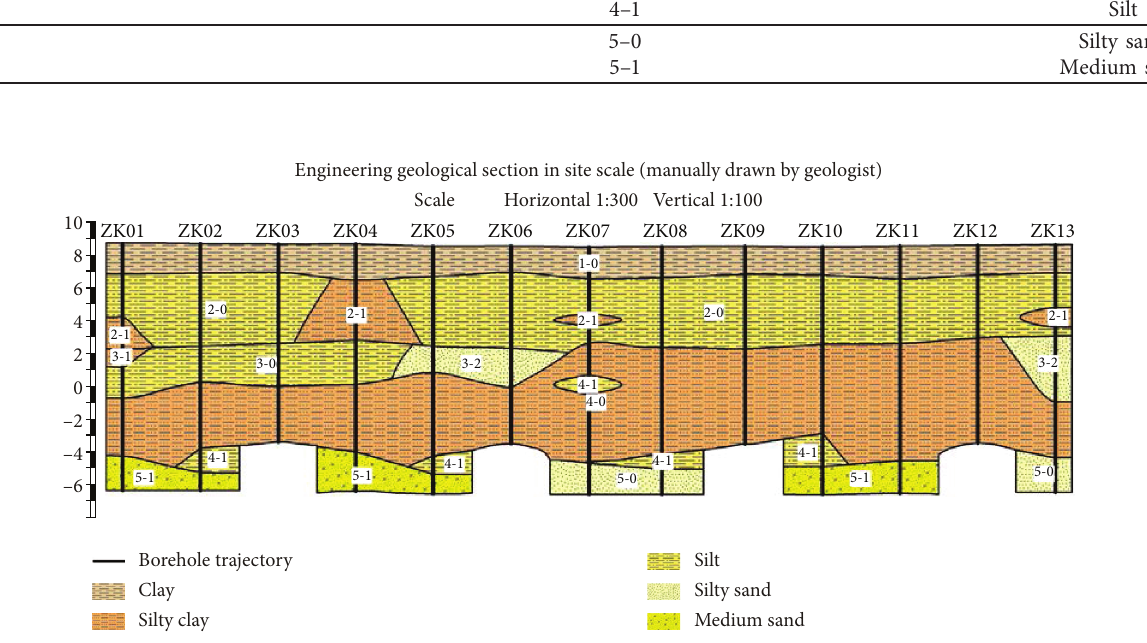
Figure 9: The engineering section drawn by geologist knowledge in site scale.